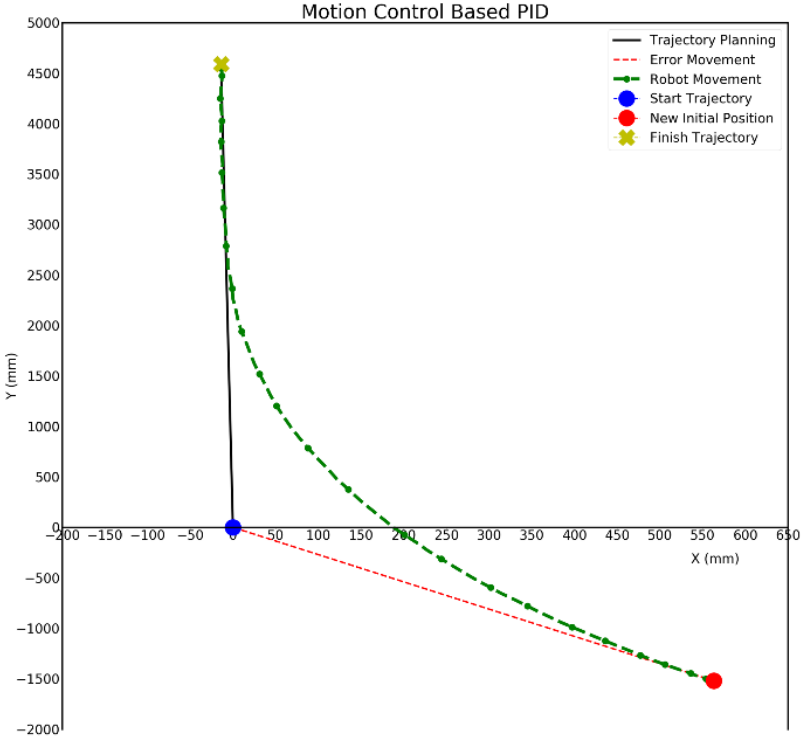
Figure 13. System Response of PID Motion Control in Coordinates of the Experimental Robot: Movement 1. In the second test, the robot was placed at (-2.5, -4.5) meters. The test result is presented in Figure 14; the robot began to follow the trajectory planning at (0.0, 2.5) meters.